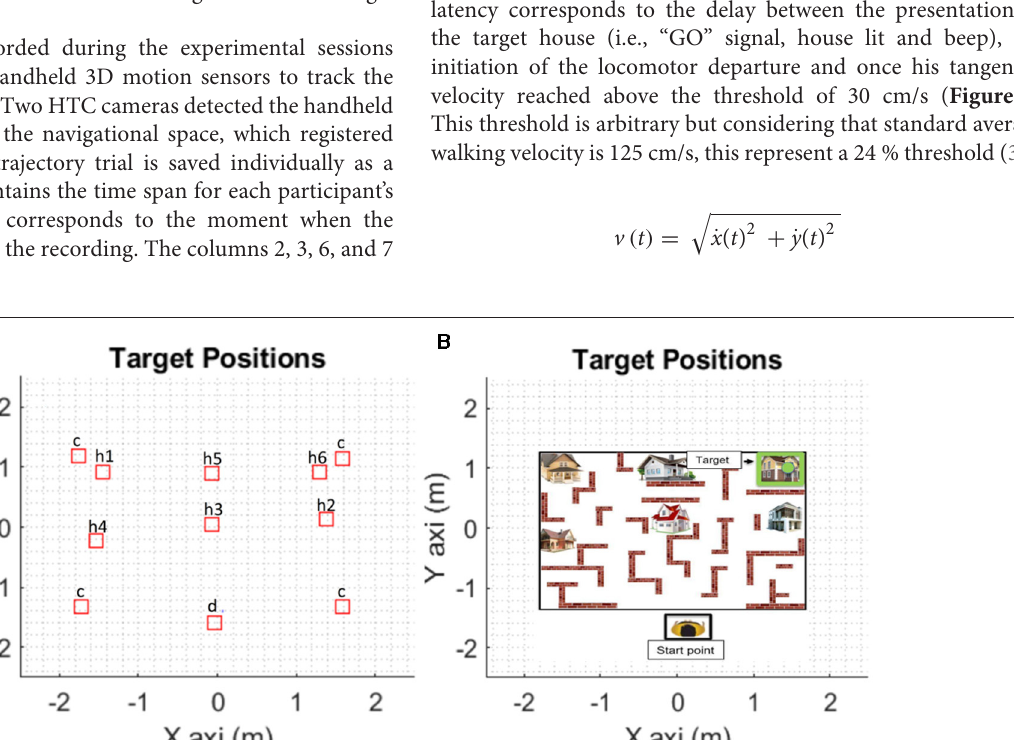
Frontiers in Psychiatry |